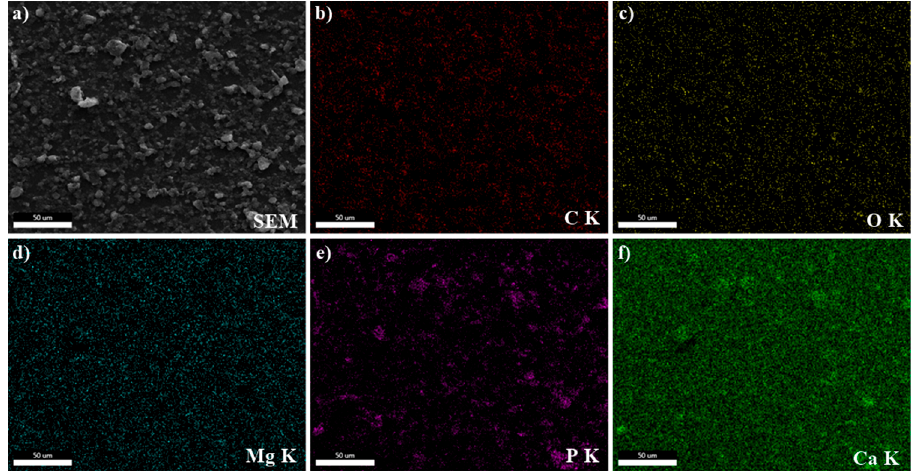
Figure 8. Elemental EDS mapping analysis of the 10MgHAp-Dex-thyme coating: ( a ) selected microscopic SEM field; ( b ) C K; ( c ) O K; ( d ) Mg K; ( e ) P K, and ( f ) Ca K. Scale bar: 50 µm.